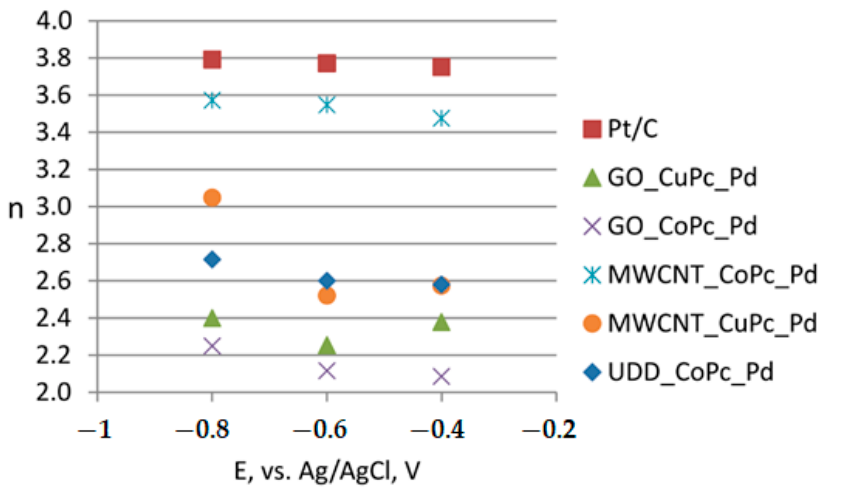
Figure 9. Calculated numbers of electrons transferred in the reaction as a function of the potential. Extrapolation of the lines to a zero value of the reverse speed of rotation of the electrode leads to a value of the reverse current that is different from zero. This indicates that the pro- cess of electroreduction of oxygen on the synthesized catalysts from an alkaline electrolyte is under the control of a mixed diffusion-kinetic limiting stage [40]. The MWCNT_CoPc_Pd catalyst is characterized by the highest value of n equal to 3.6. For this catalyst, the number of electrons remains almost constant at all used potentials, and indirectly indicates the predominance of water in the final reaction product. For other synthesized catalysts, the value of n is much lower and sharply decreases when the potential is shifted to a more positive region. This indicates the predominance of the side reaction with the formation of the HO 2 −